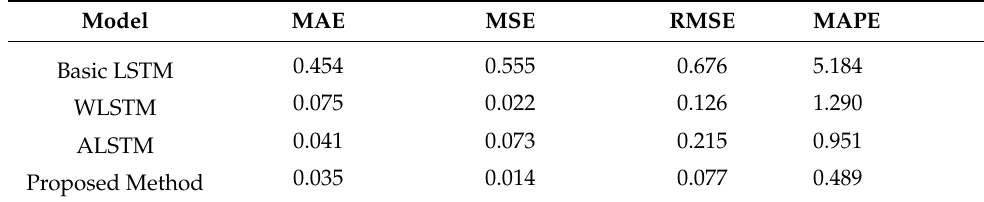
Table 4. Quantitative comparison without missing data.